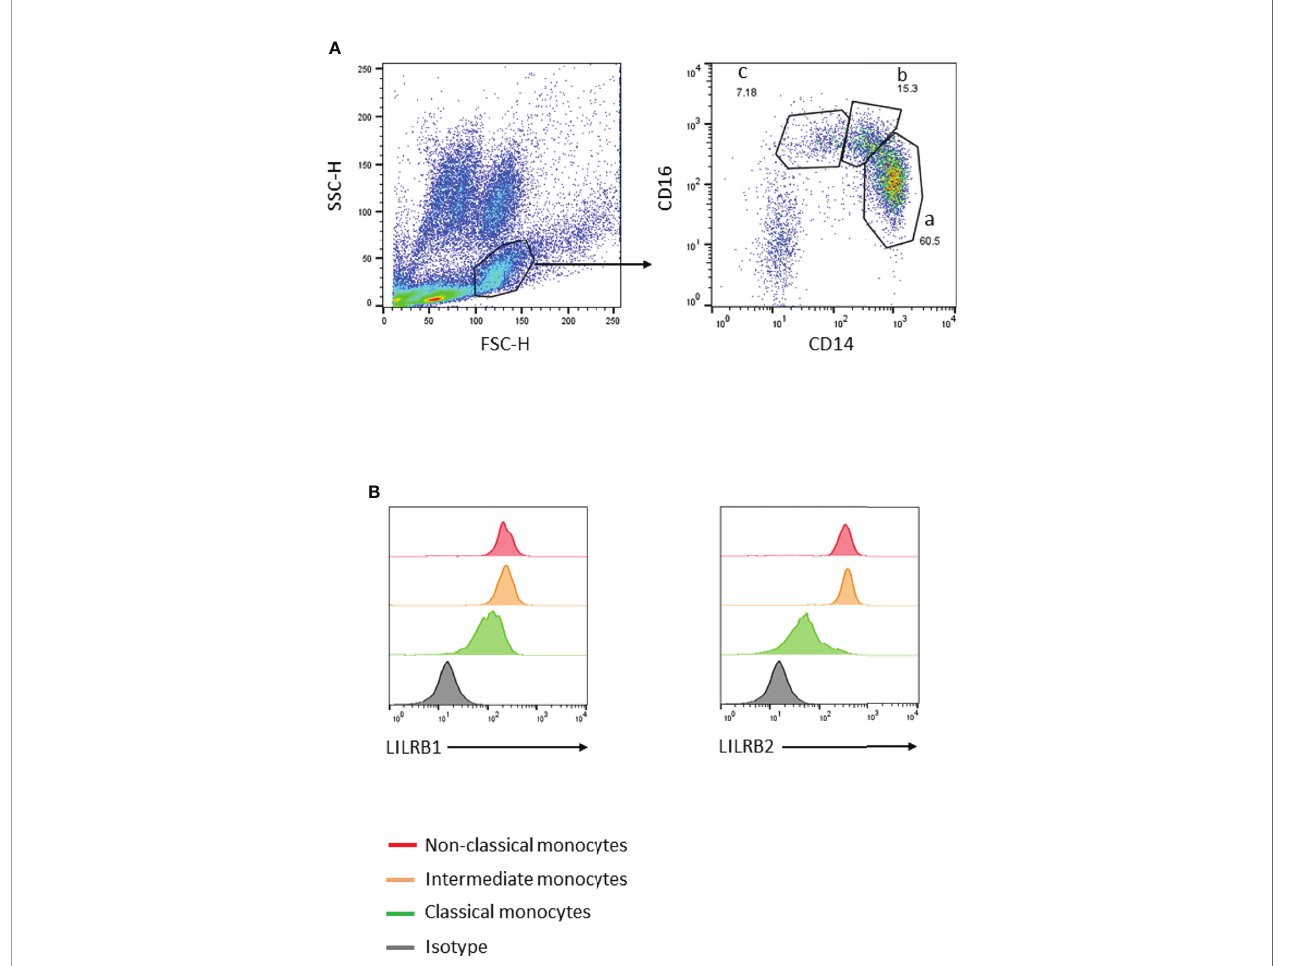
FIGURE 1 | Gating strategy to identify peripheral blood monocyte subsets. (A) Monocytes were gated using forward- and side-scatter properties. The 3 subsets were characterized through expression of CD14 and CD16 markers (a: classical CD14 ++ CD16 – , b: intermediate CD14 ++ CD16 + , and c: non-classical CD14 + CD16 ++ ). (B) LILRB1 or LILRB2 expression levels on the 3 monocyte subsets were de fi ned using histogram geometric